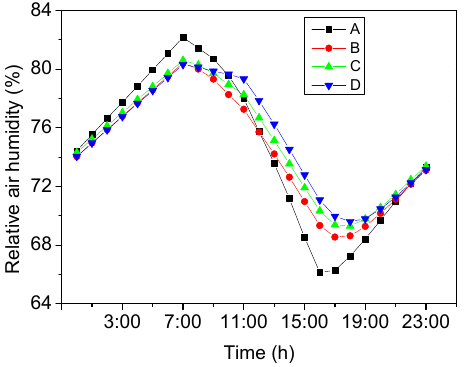
relative air humidity parameter, while the variation of the other three curves is minimal. The highest relative air humidity at the inlet is 82.18% at 7:00, and the lowest relative air humidity is 66.13% at 16:00. The lowest relative air humidity of the remaining three points occurs between 17:00 and 18:00.